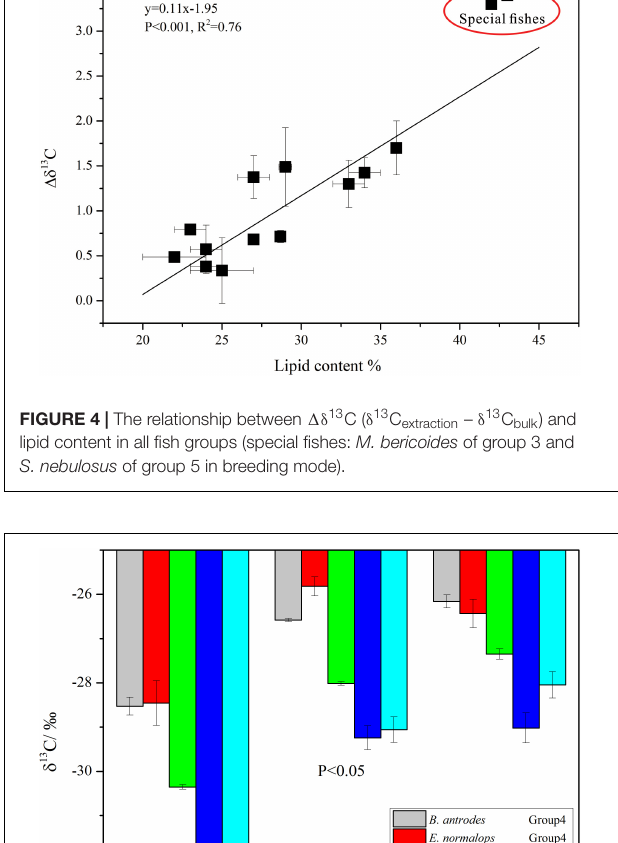
FIGURE 3 | δ 15 N versus δ 13 C in different fish groups: (A) δ 15 N versus δ 13 C bulk (bulk–tissue δ 13 C); (B) δ 15 N versus δ 13 C extraction (the lipid extracted δ 13 C) (group 1, migrant planktivorous fishes; group 2, migrant piscivorous fishes; group 3, non-migrant planktivorous fishes; group 4, non-migrant piscivorous fishes; group 5, semi-migrant piscivorous fishes; special fishes: Melanolagus bericoides of group 3 and Stomias nebulosus of group 5 in breeding mode).